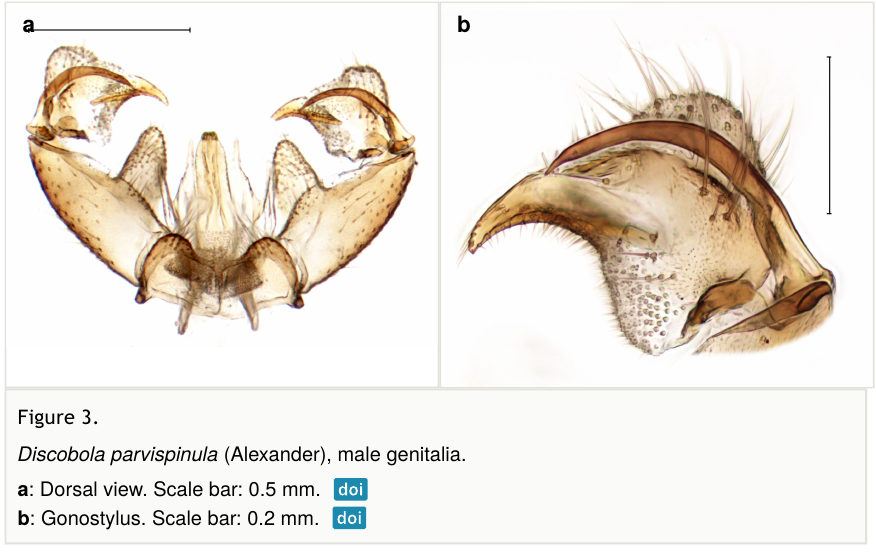
Figure 3. Discobola parvispinula (Alexander), male genitalia. a : Dorsal view. Scale bar: 0.5 mm. b : Gonostylus. Scale bar: 0.2